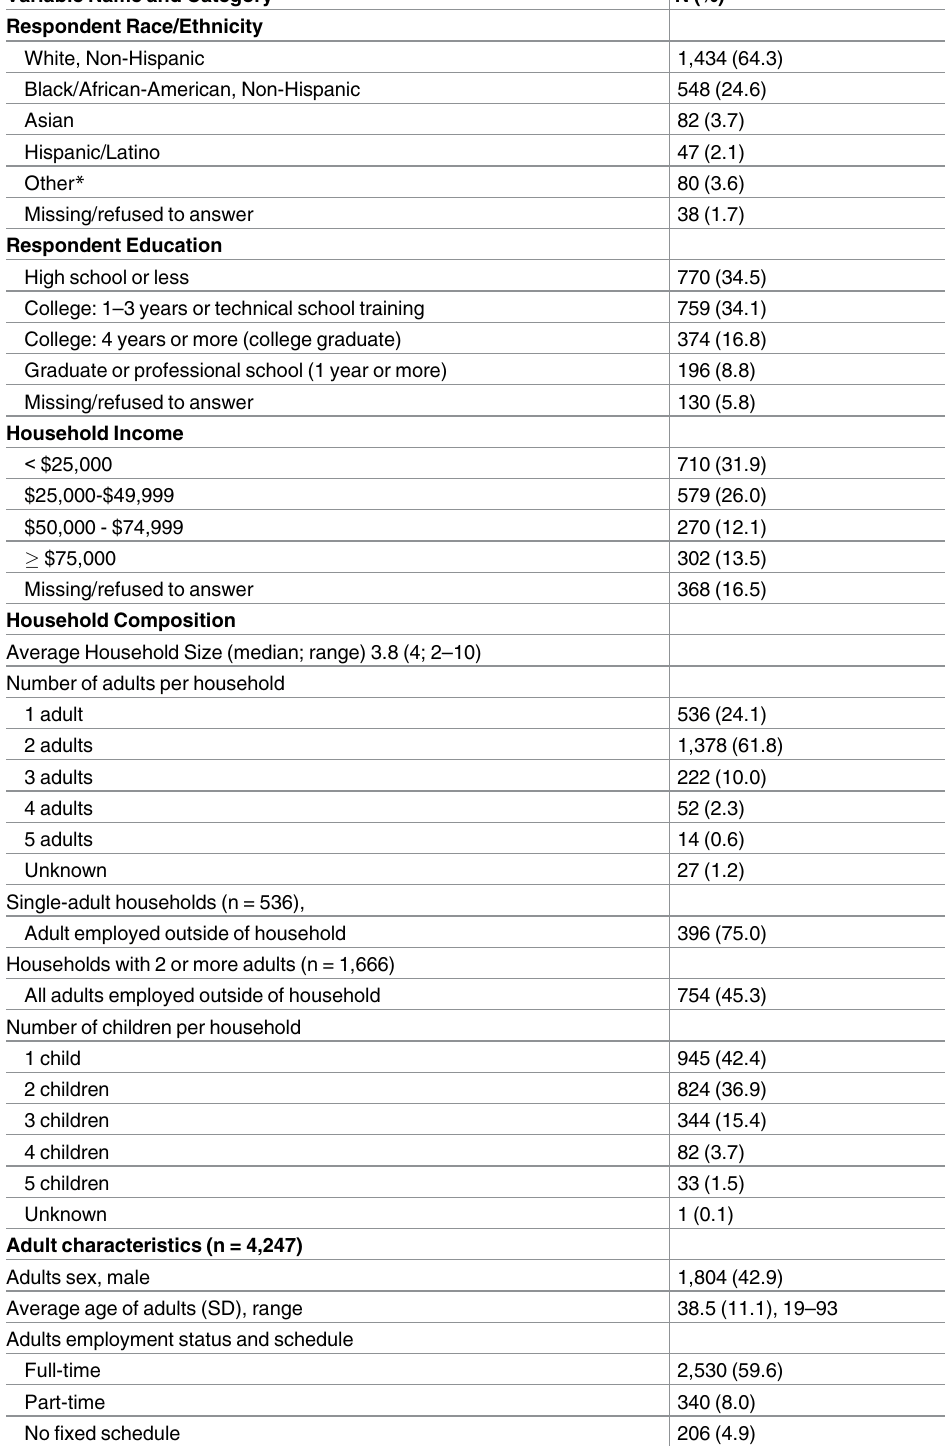
Table 1. Demographic and economic characteristics of survey respondents and households. Unplanned School ClosureHouseholdSurvey, HarrisonCounty School District, Mississippi, August 2012 (N =